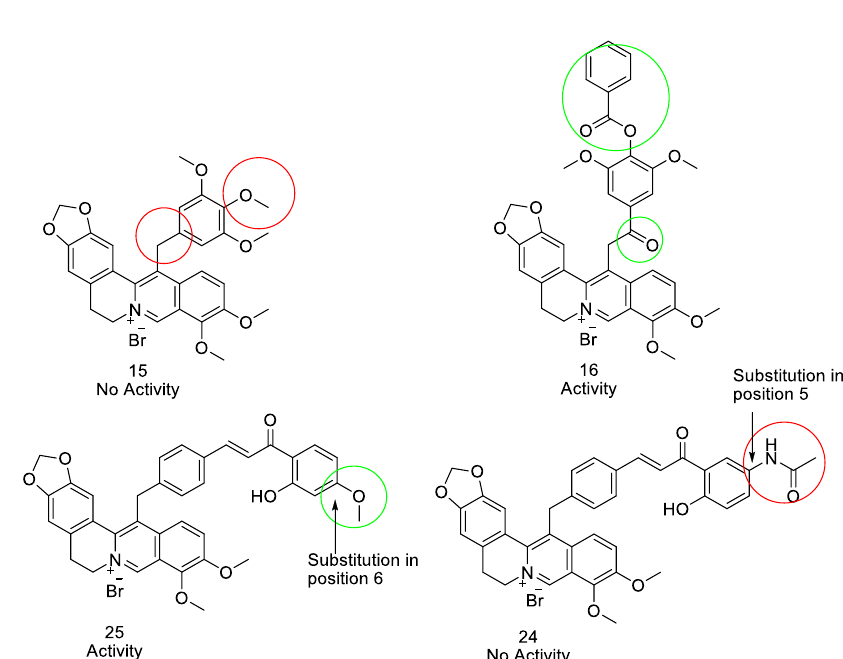
Figure 3. Comparison of the structure of closely related compounds found active or inactive. Structure of compounds 15 (inactive) and 16 (active) and compounds 24 (inactive) and 25 (active) are shown for comparison.